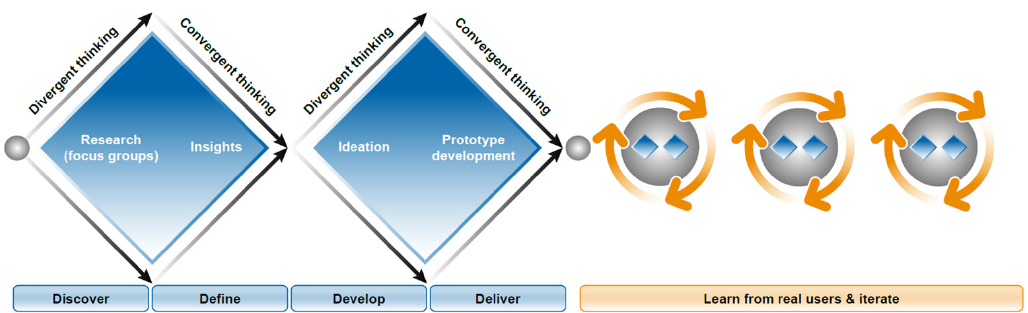
Figure 1. Double Diamond model, an iterative approach with rapid prototyping.